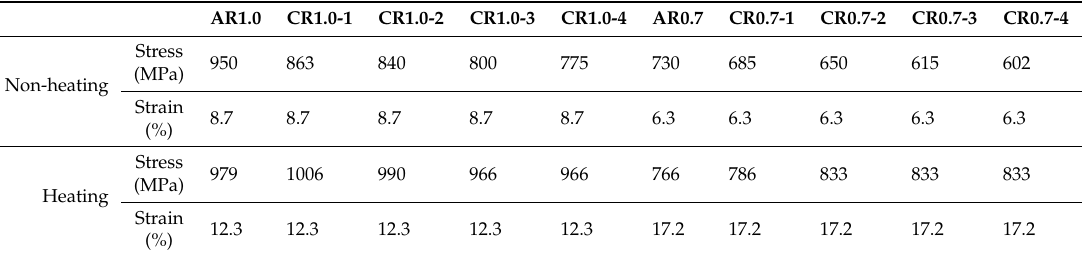
Figure 6. Tensile behavior of AR and crimped: ( a ) non-heated 1.0-mm diameter fibers; ( b ) non-heated 0.7-mm diameter fibers; ( c ) heated 1.0-mm diameter fibers; and ( d ) heated 0.7-mm diameter fibers. Table 3. Yield stress of AR and CR fibers and the corresponding